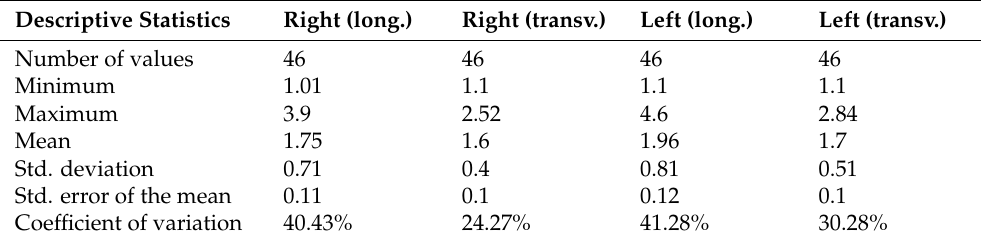
Table 3. Ultrasound thickness measurements of the thoracolumbar fascia at the L3 level of the lumbar spine in the healthy volunteers.